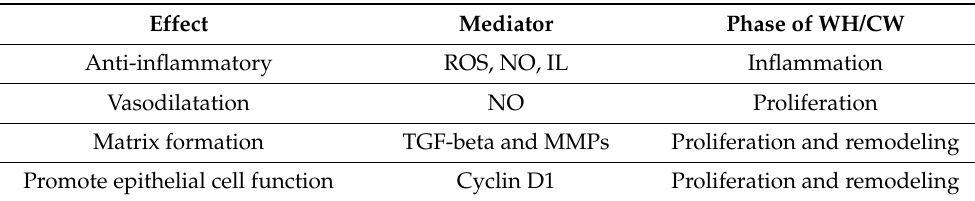
Table 5. Summary of the beneficial effects of photobiomodulation (PBM) in wound healing (WH) and chronic wound